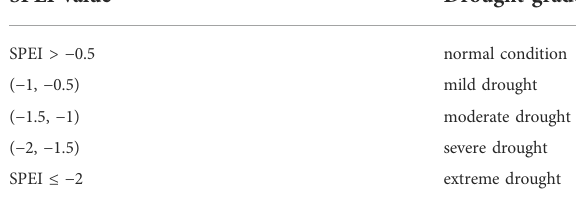
TABLE 1 Range of SPEI values corresponding to different drought